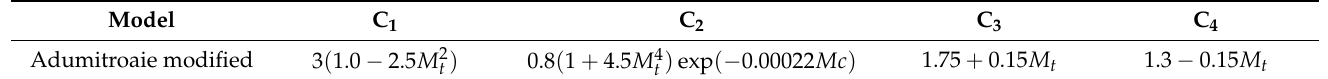
Table 5. Numerical coefficients of the pressure-strain